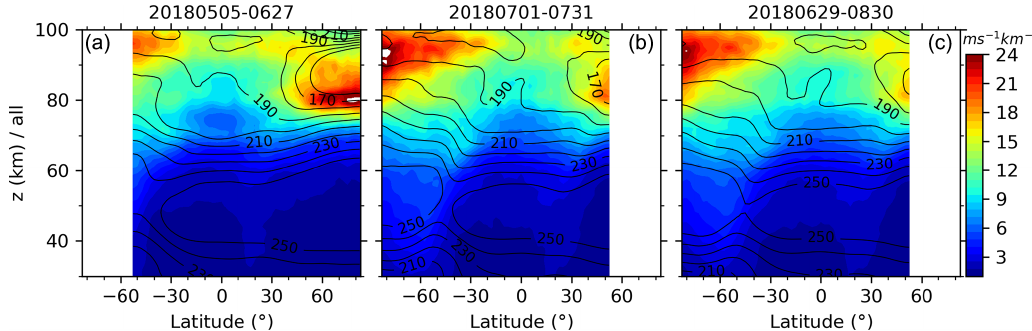
Figure 11. Same as Fig. 4 but for the zonal-mean GW-perturbed shears with a cutoff criterion of 3km.